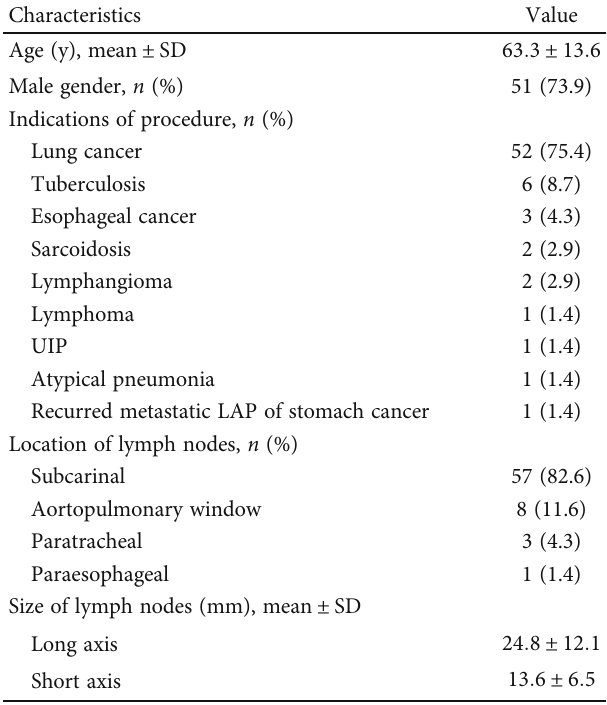
Table 1: Baseline characteristics of the study cohort ( n = 69 ).